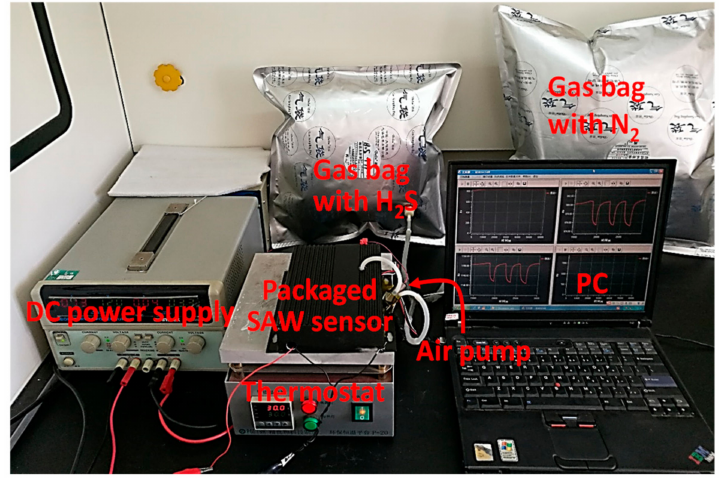
Figure 6. The experimental setup for evaluation of the proposed SAW